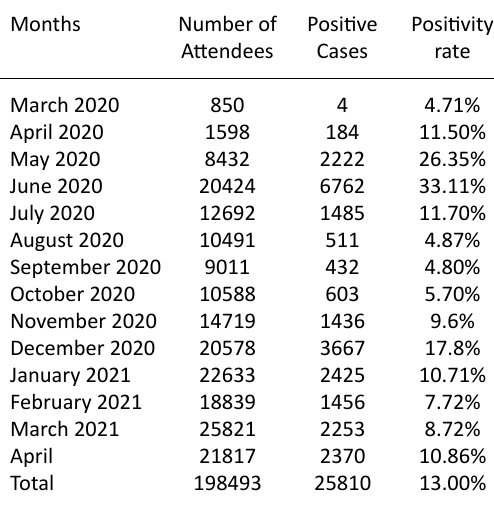
Table 1. The COVID-19 PCR positivity rates from March